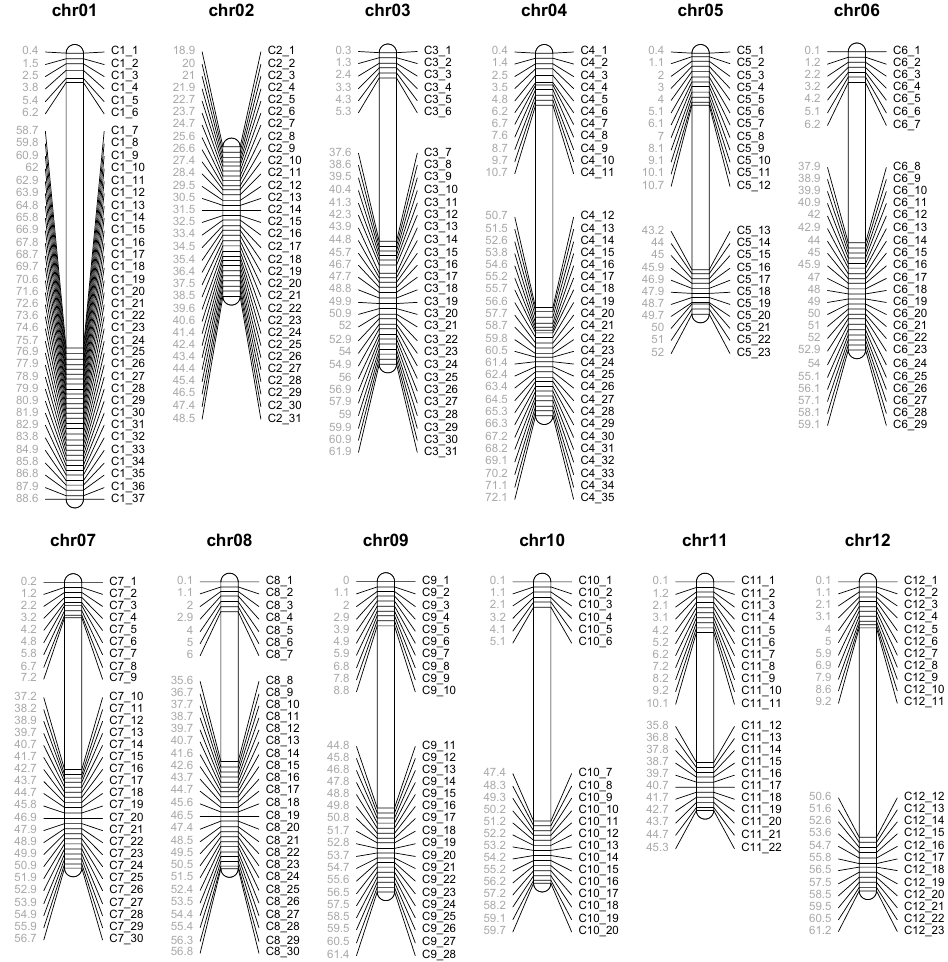
Figure 4. The physical map of potato based on pseudochromosome molecule assembly of the DM_v4.04 reference sequence. The positions of the 339 PotatoMASH core loci are represented in Mb